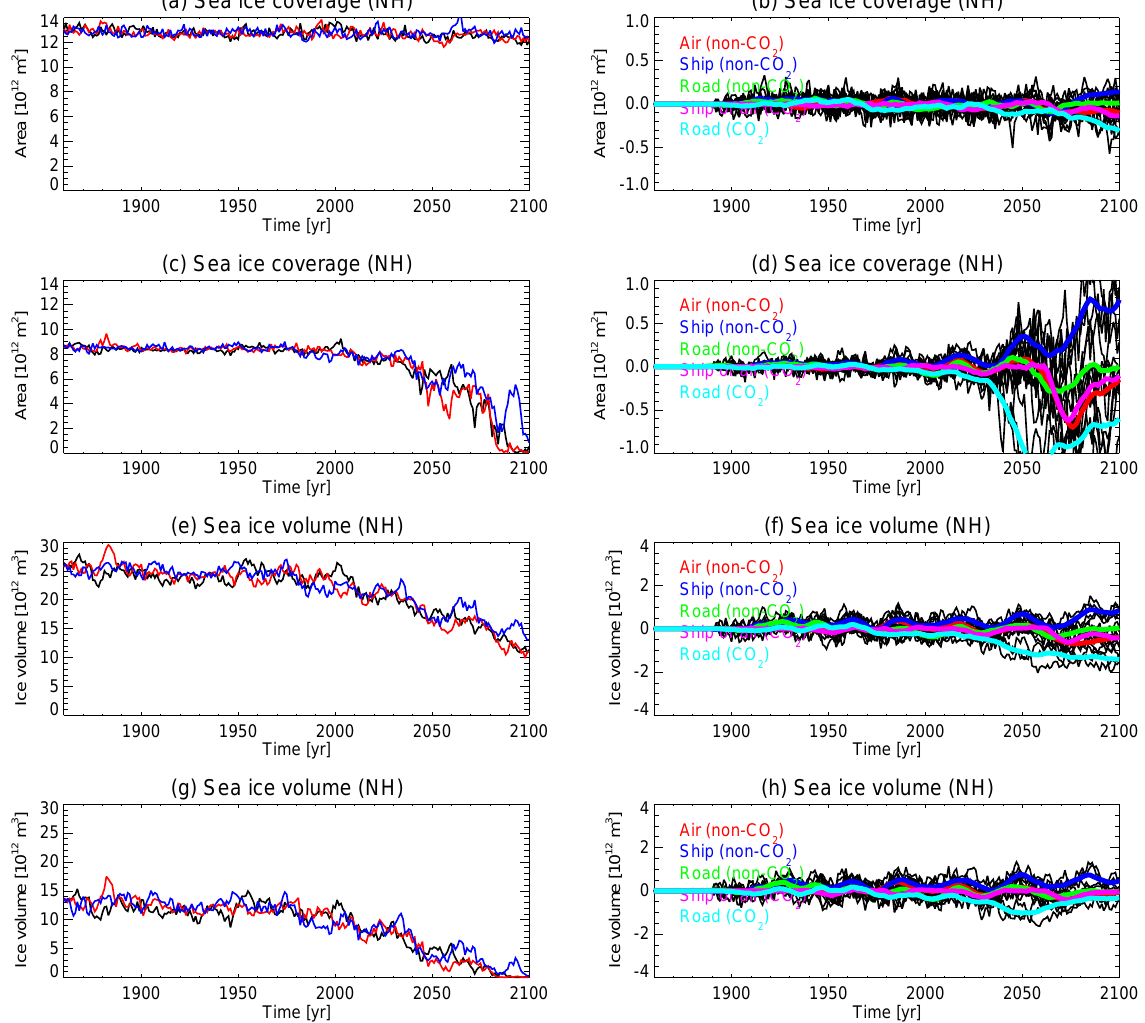
Fig. 21. Left: time series in the reference simulation of (a) NH sea-ice coverage (in 10 12 m 2 ) in March, (c) NH sea-ice coverage in September, (e) NH sea-ice volume (in 10 12 m 3 ) in March and (g) NH sea-ice volume in September. Right: the impact by road transport, shipping and aviation, separately for their CO 2 and non-CO 2 impact on (b) NH sea-ice coverage in March, (d) NH sea-ice coverage in September, (f) NH sea-ice volume in March and (h) NH sea-ice volume in September. half of the 21st century, showing large variability within and among the different simulations. Importantly, two of the sim- ulations have no sea-ice in 2100 in the Arctic in September. The large variability in the Arctic sea-ice cover corresponds with a large variability in the local surface air